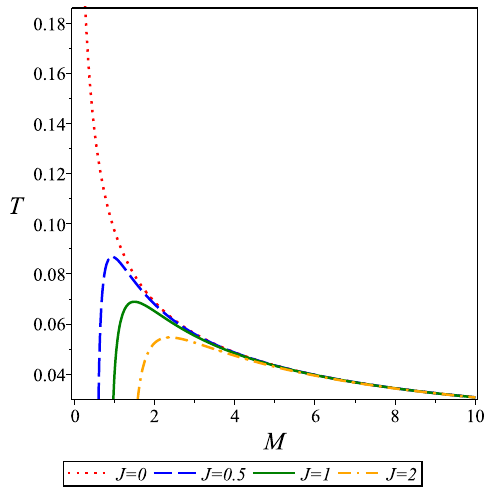
Figure 1 . Temperature of the Myers-Perry black hole in terms of